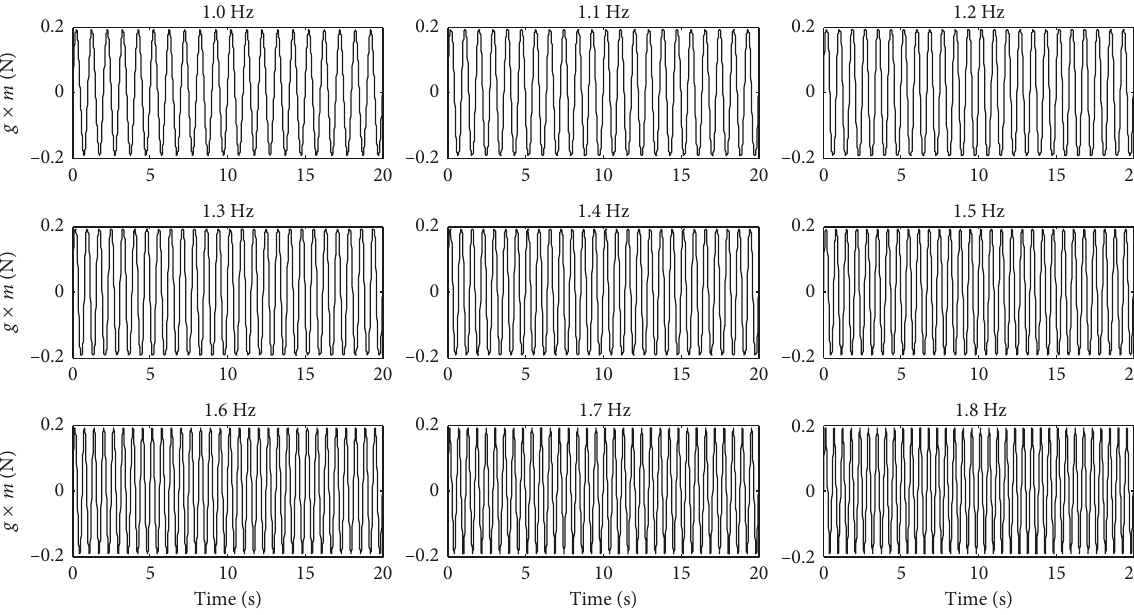
Figure 20: The nine simulated crowd swaying loads at nine frequencies. Table 10: Calculation of eigenvalues for natural